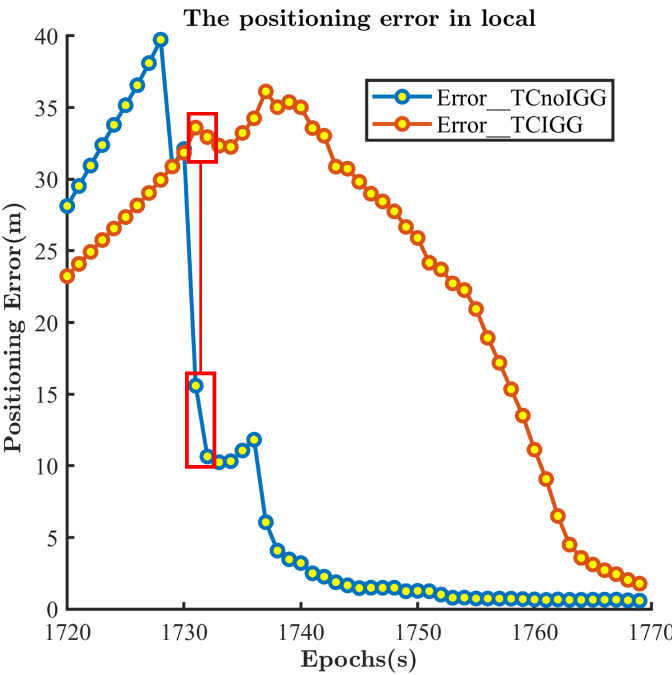
Figure 13. The positioning error in local.